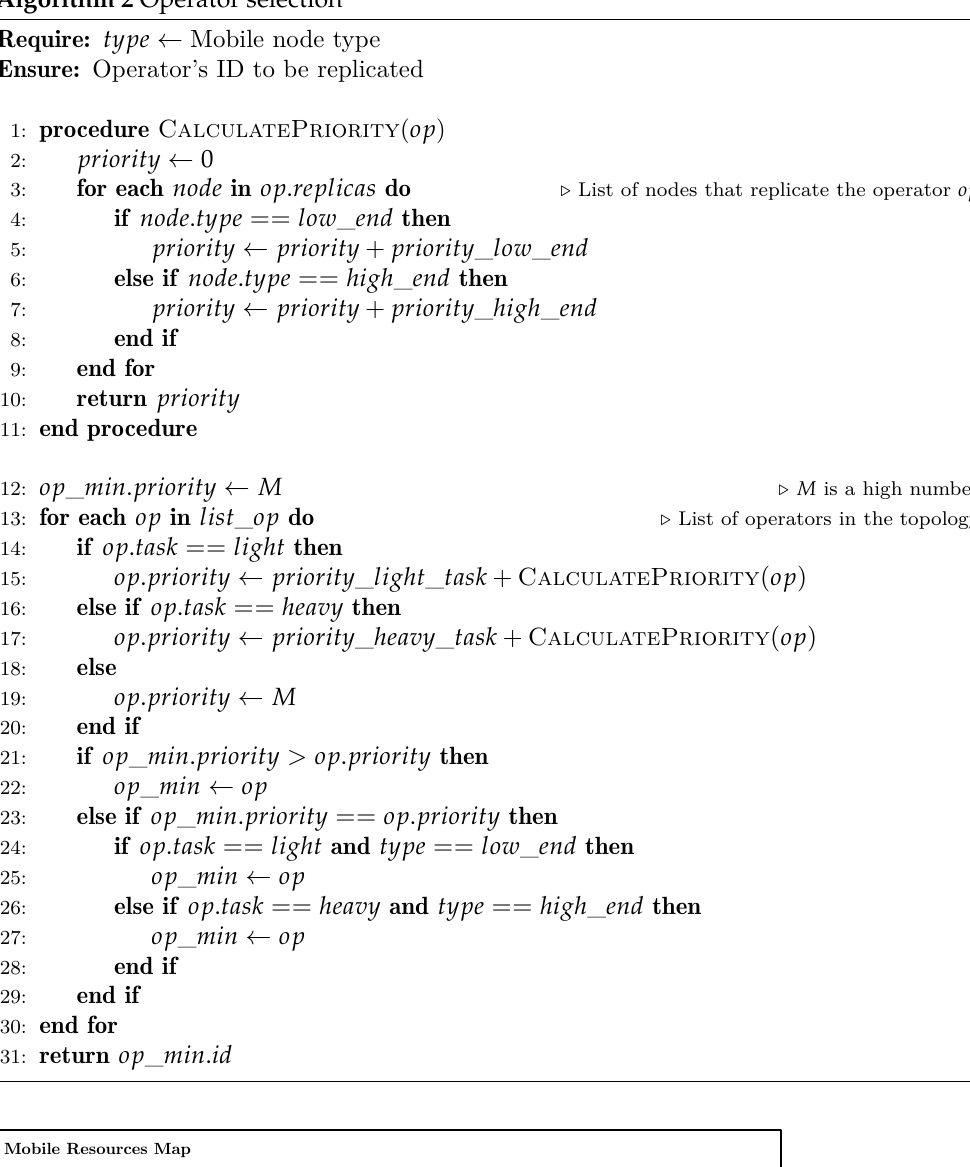
Algorithm 2 Operator selection